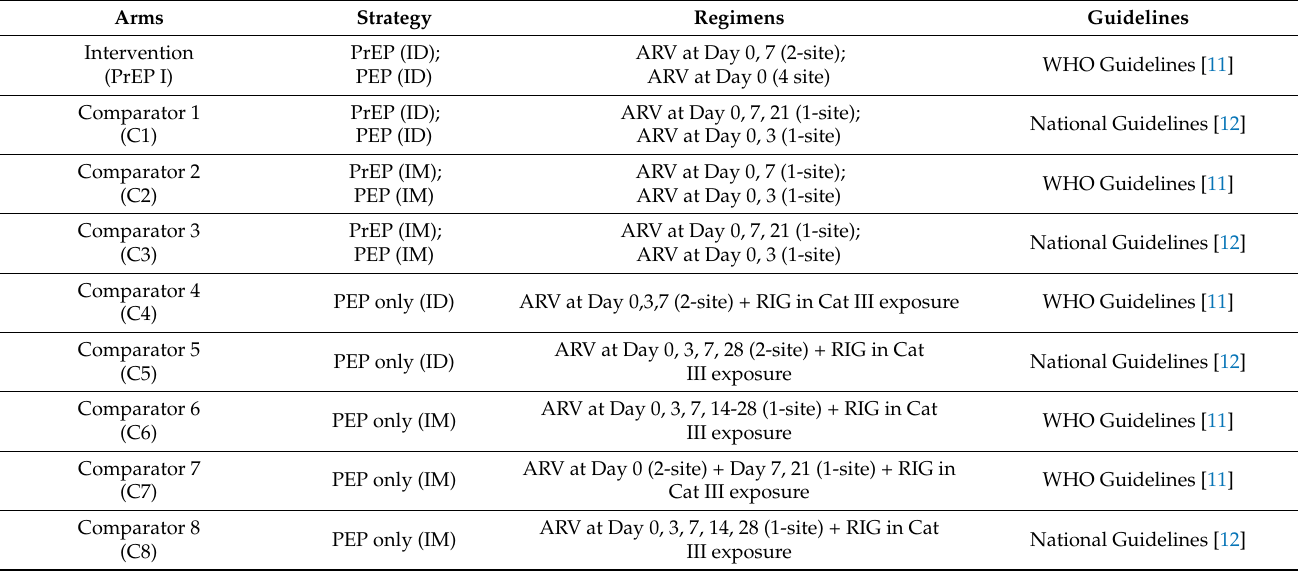
Table 1. Vaccine Schedule for Intervention and Comparator